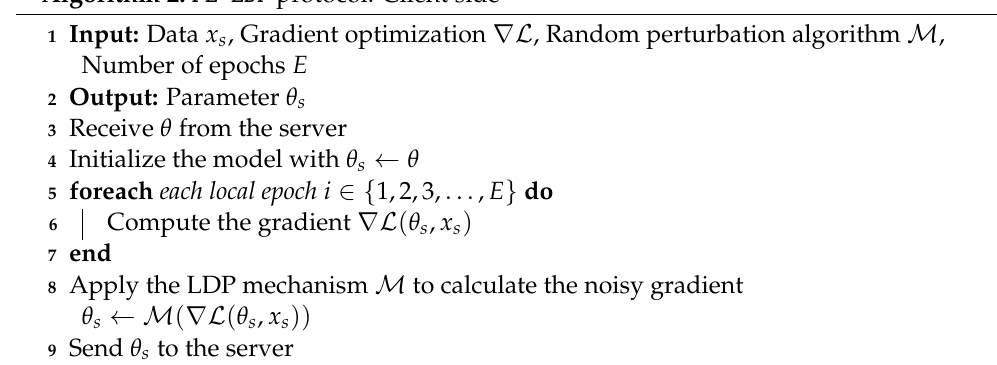
Algorithm 2: FL-LDP protocol: Client